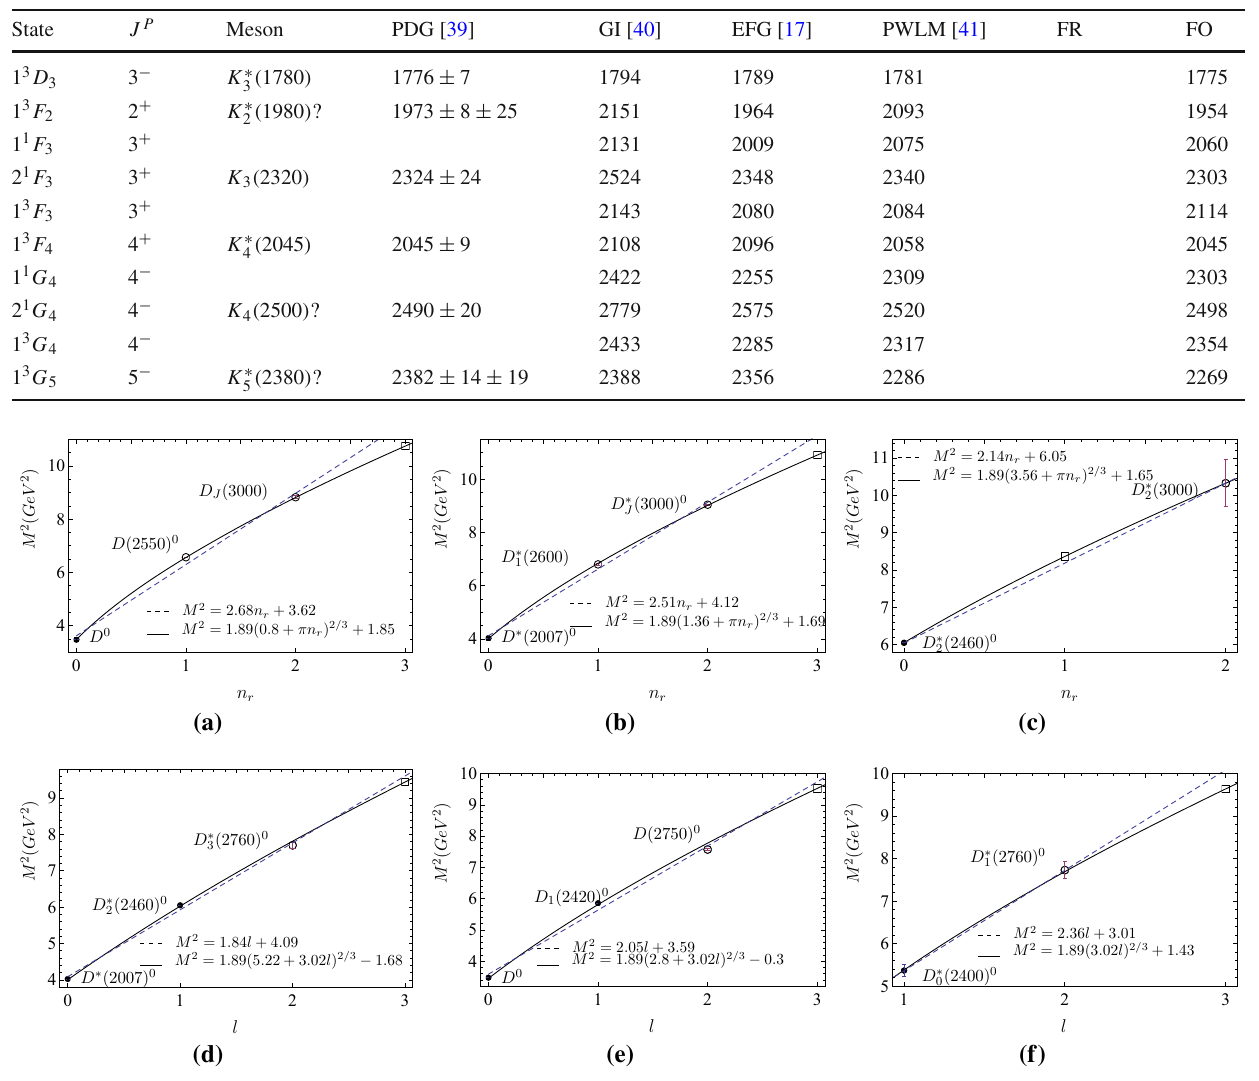
Fig. 3 The radial and orbital Regge trajectories for the charmed mesons. The used data are listed in Table 2. The well-established states are given by solid dots. The unwell-established states or the states needing confirmation are given by circles. Open squares are predicted masses by the fitted Regge trajectories